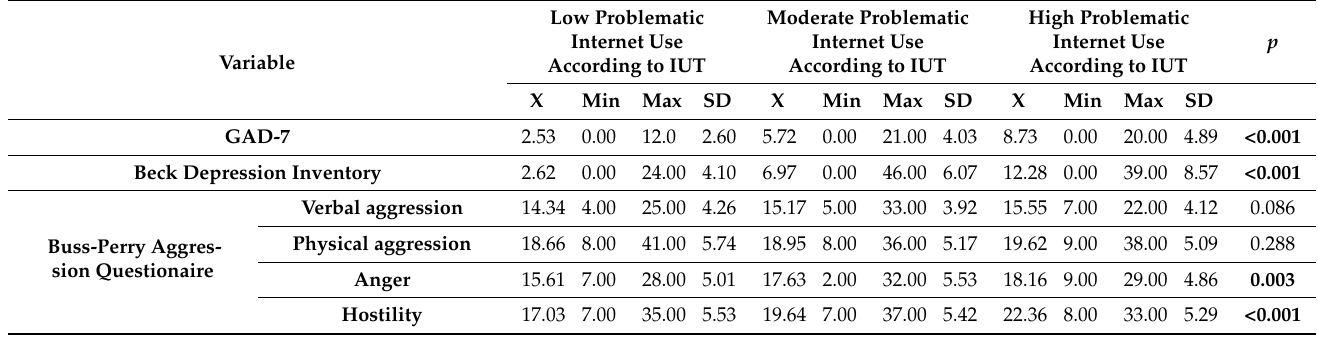
Table 2. Results of the questionnaires used in the study vs. IUT problematic Internet use. Low Problematic Moderate Problematic Internet Use Internet Variable According to IUT